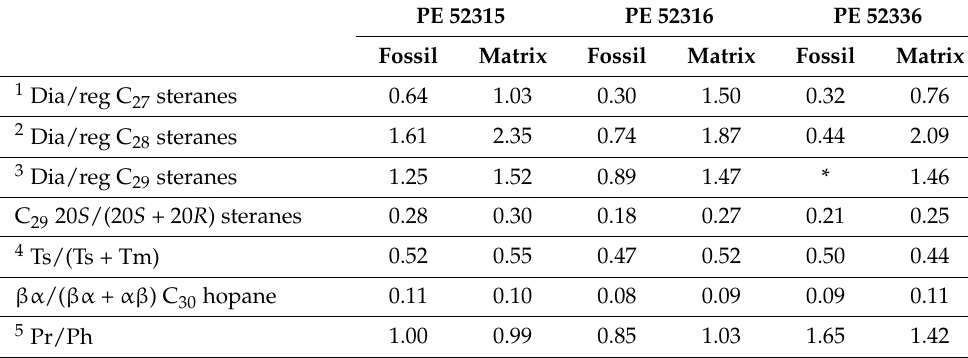
Table 3. Biomarker parameters in extracts of coprolite